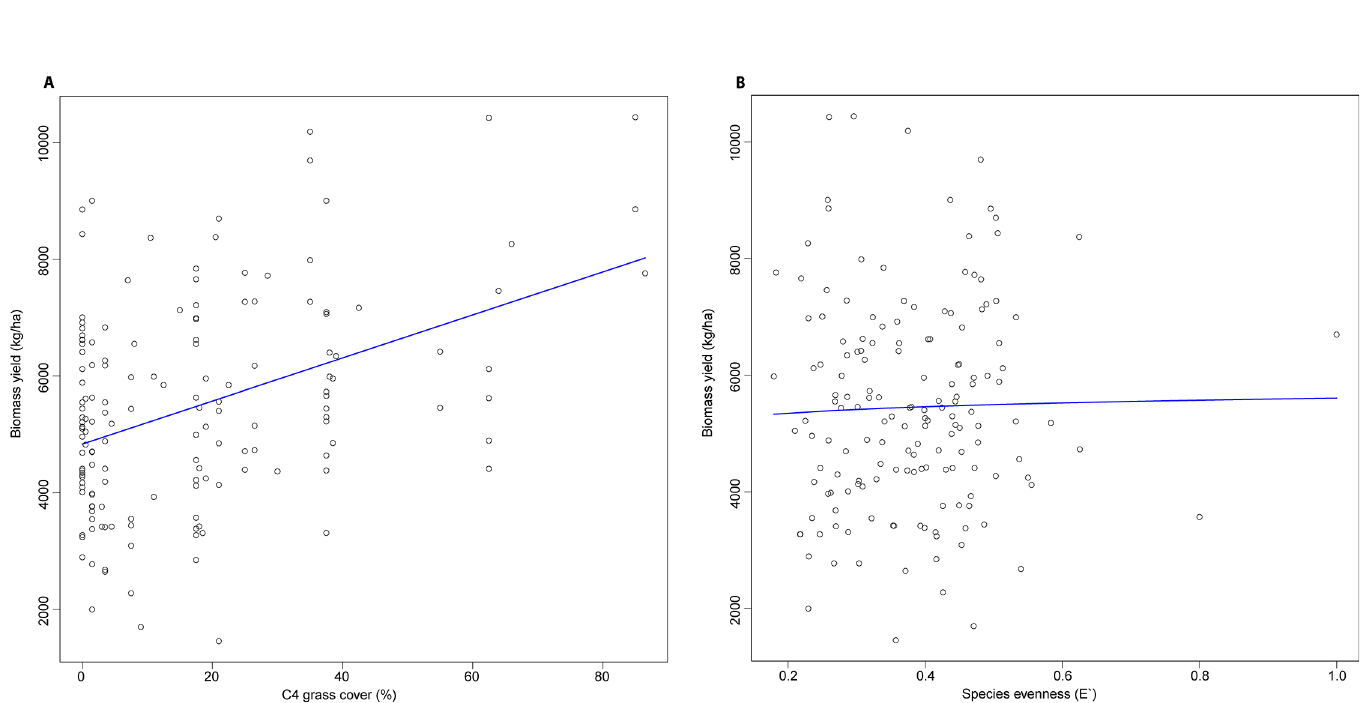
Fig 3. Variable plots for the model average for 2008 data. The regression line for multiple regression is displayed as the intercept and slope for the indicated predictor variable with the mean of all other variables held constant. Coefficients for each model are listed in Table 4. Log-transformed variables have been back-transformed. (A) The relationship between the percent of C4 grass cover within 1 m 2 plots and biomass yield (kg/ha). (B) The relationship between species evenness within 1 m 2 plots and biomass yield